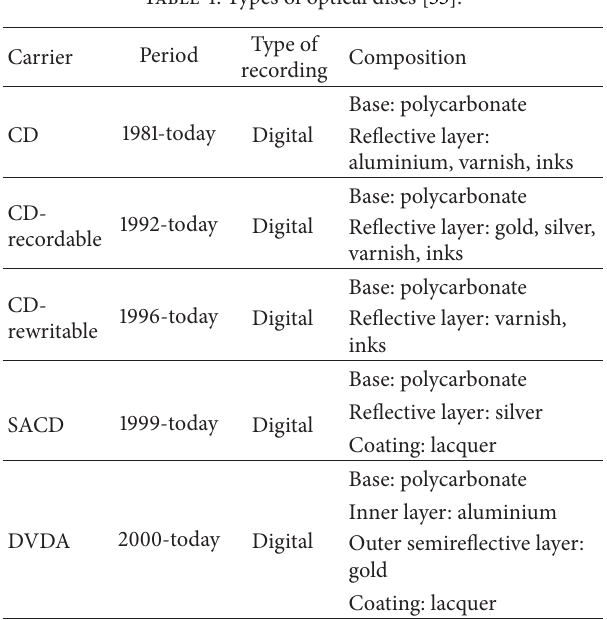
Table 4: Types of optical discs